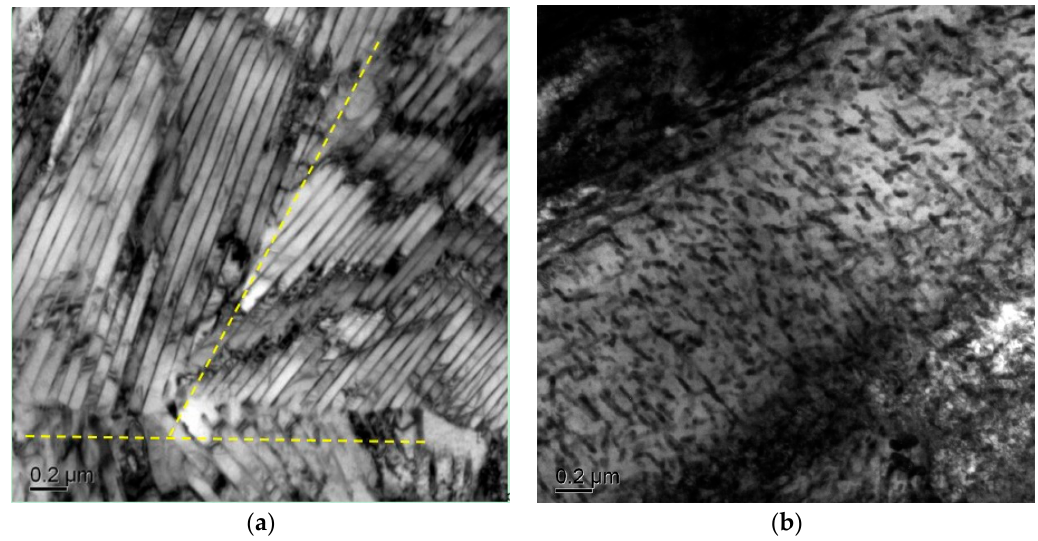
Figure 5. Typical TEM micrographs of pearlitic colonies ( a ) and tempered martensite ( b ) after annealing.